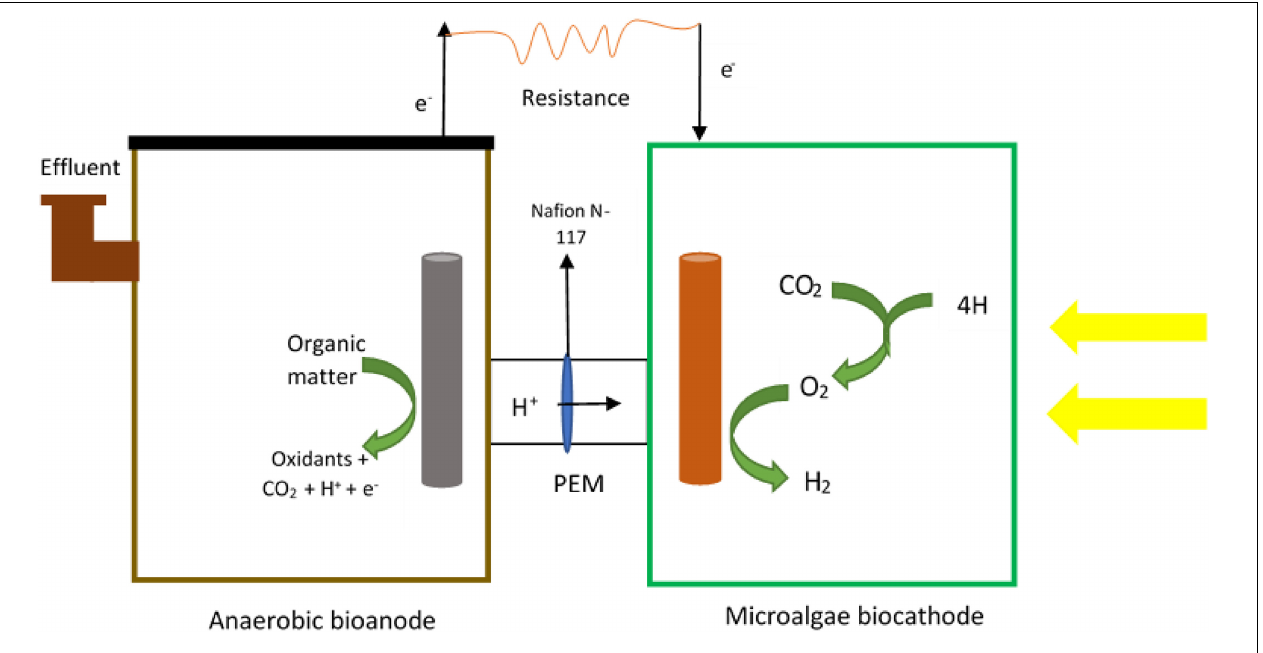
FIGURE 2 | Schematic production of bioelectricity by microalgae in two-chambered